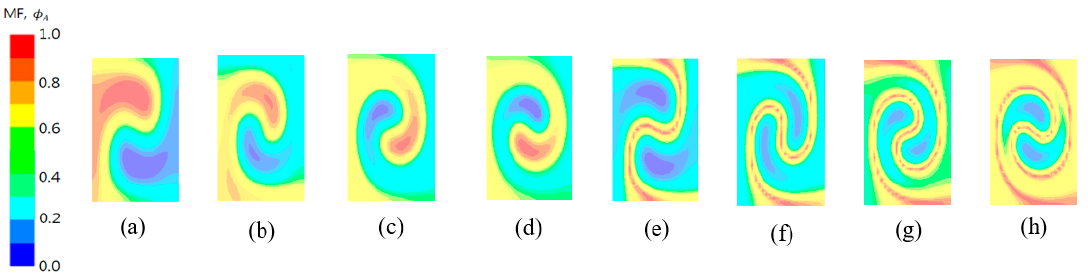
Figure 8. Mass fraction of fluid A and mixed fluid contours at the cross section of θ i = 8 π for several twist angles: contours of ϕ A for ( a ) θ = 12 π , ( b ) θ = 16 π , ( c ) θ = 20 π and ( d ) θ = 24 π , contours of MF for ( e ) θ = 12 π , ( f ) θ = 16 π , ( g ) θ = 20 π and ( h ) θ = 24 π .